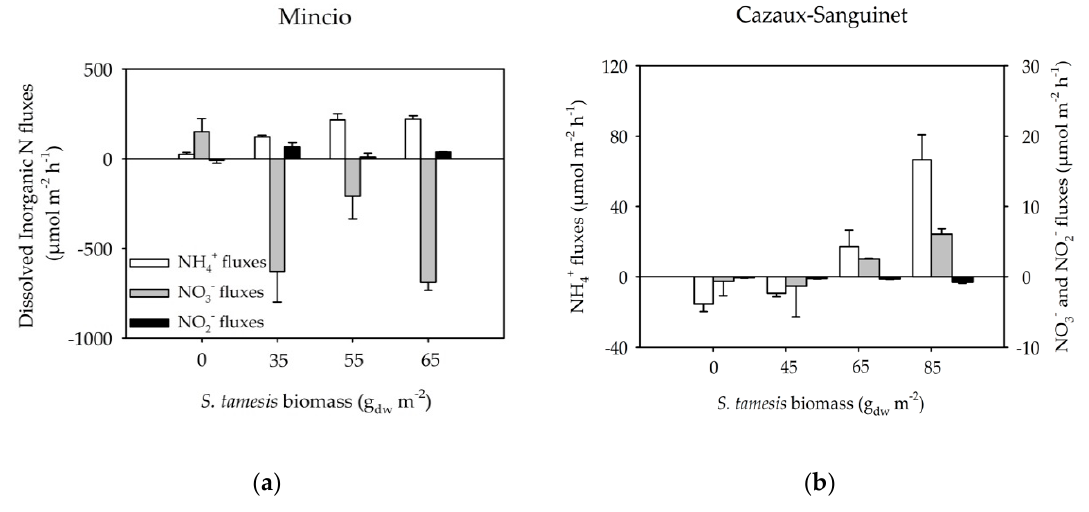
Figure 4. Benthic fluxes of N forms (NH 4+ , NO 3 − , and NO 2 − ) expressed in µmol m − 2 h − 1 measured during dark incubation in the sediment from the Mincio River ( a ) and from the Cazaux-Sanguinet Lake ( b ). Averages ± standard errors are reported. Note different scales on y -axes.